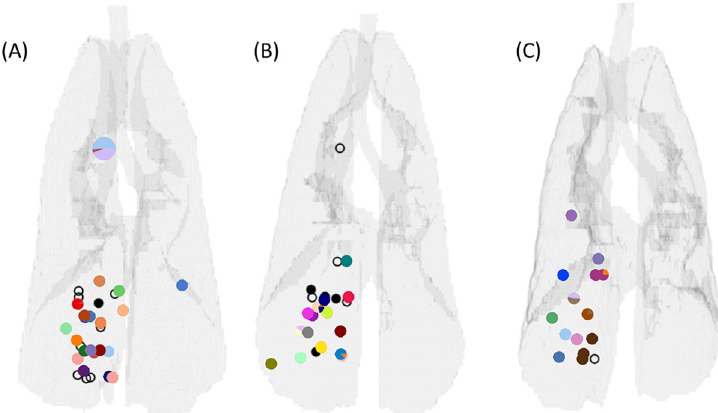
Fig 1. Three NHP lung maps illustrating the positioning of pulmonary granulomas and thoracic lymph nodes (data previously published in Martin et al. [25]). Gray outlines denote the extent of the lungs, bronchial tubes, and trachea. Small markers superimposed on the outlines represent the positions of pulmonary granulomas, while larger markers denote lymph nodes. Colors denote unique barcode tags. Some samples had more than one barcode tag present, and often these were doublet granulomas (i.e., two granulomas too close in proximity to distinguish at necropsy) and so are marked with a pie chart showing the relative abundance of each barcode tag. The black markers represent pulmonary granulomas for which no barcode tags were found. Filled black markers are granulomas which grew bacteria upon plating but barcodes could not be determined for technical reasons, while open markers are granulomas that did not grow bacteria upon plating